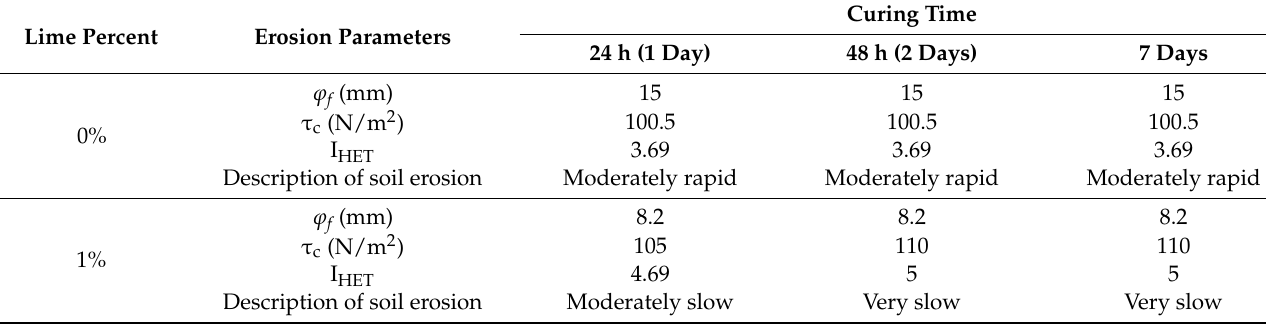
Table 5. Final erosion parameters of Soil